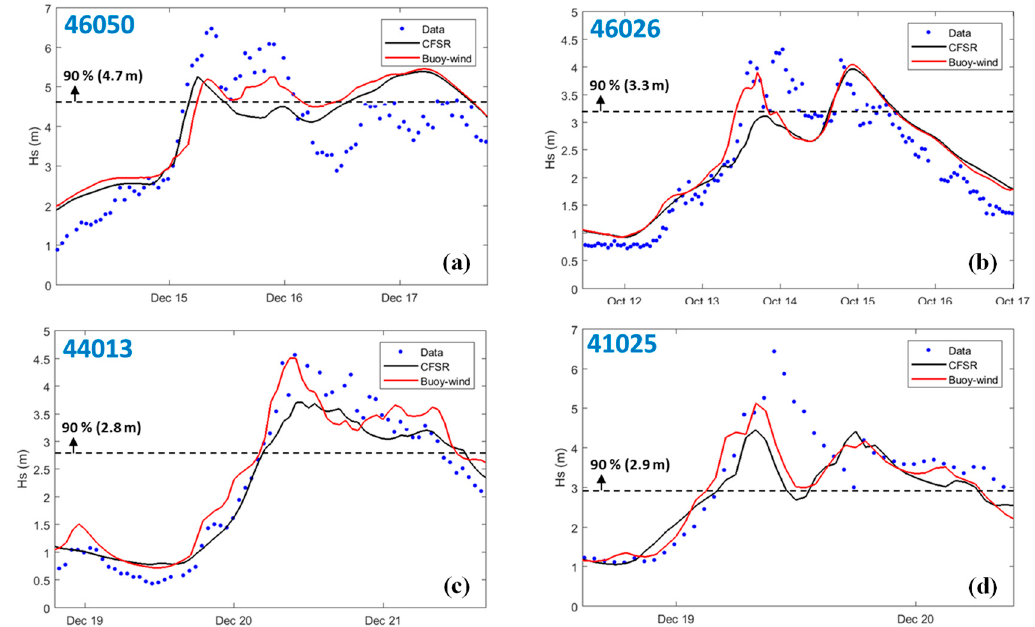
Figure 7. Comparison of significant wave heights between the baseline condition, observed-wind condition, and buoy observations at all four buoys (( a )—46050; ( b )—46026; ( c )—44013; and ( d )—41025) for the example large-wave events in 2009. Table 4. Performance metrics for large (>90th percentile of significant wave height) waves only.